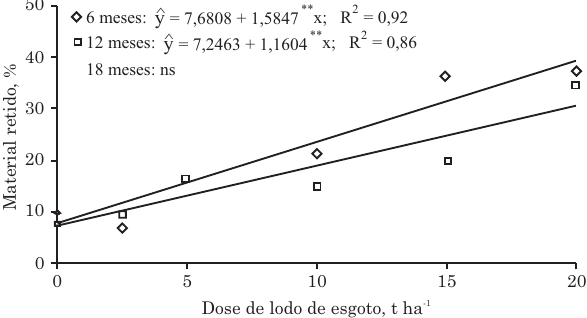
Figura 2. Quantidade de agregados formados (retido em peneira de 2 mm) em função de doses de lodo de esgoto adicionado ao solo, 6 e 12 meses após sua aplicação. ** = significativo a 1 %; ns = não